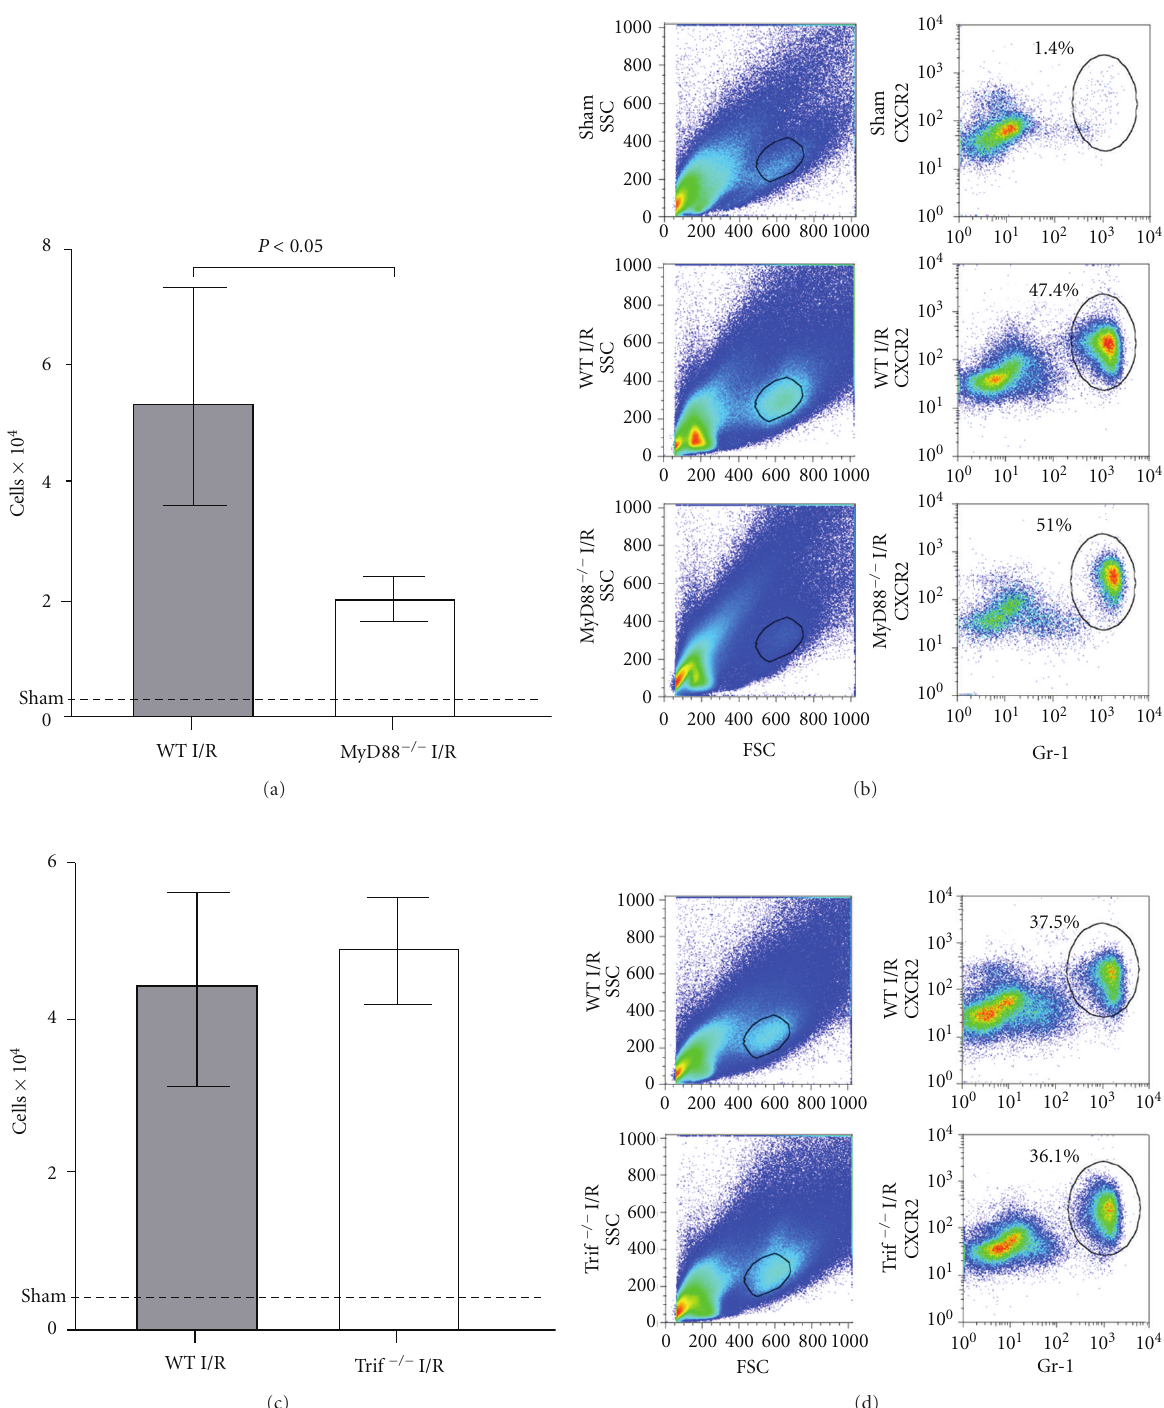
Figure 2: Myocardial neutrophil recruitment after I/R in MyD88 − / − and Trif − / − mice. Twenty-four hours after 60 min of left anterior descending coronary artery (LAD) ligation, the hearts were isolated, perfused, and digested. After removal of the large cardiomyocytes through filtration, 50% of total cells were loaded onto flow cytometry and gated on Gr-1 and CXCR2. (a) Total Gr-1+ cells as measured by flow cytometry from the hearts subjected to I/R in MyD88 − / − mice. Each error bar represents mean ± SD of 4 mice. A small number of neutrophils were recovered from the sham-operated hearts as indicated by the line. (b) A representative example of flow cytometry plots of myocardial infiltrating cells from sham, WT-I/R, and MyD88 − / − -I/R mice. (c) Total Gr-1+ cells as measured by flow cytometry from the hearts subjected to I/R in Trif − / − mice. Each error bar represents mean ± SD of 3 mice. A small number of neutrophils were recovered from the sham-operated hearts as indicated by the line. (d) A representative example of flow cytometry plots of myocardial infiltrating cells from WT-I/R and Trif − / − -I/R mice. FSC, forward scatter; SSC, side scatter. (Feng et al., [100], used with